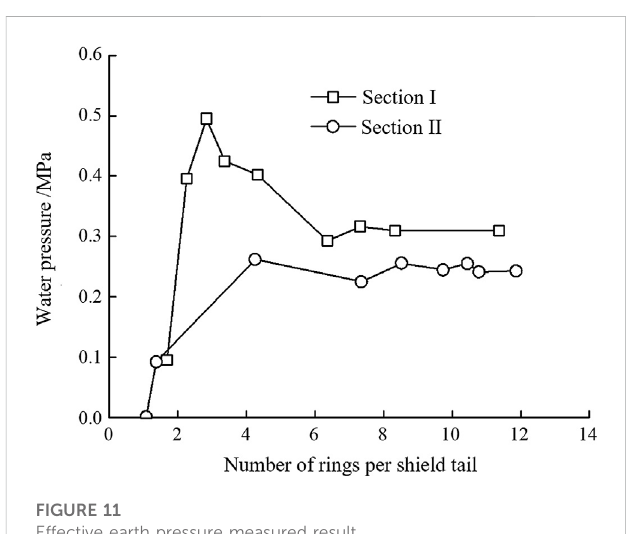
FIGURE 11 Effective earth pressure measured